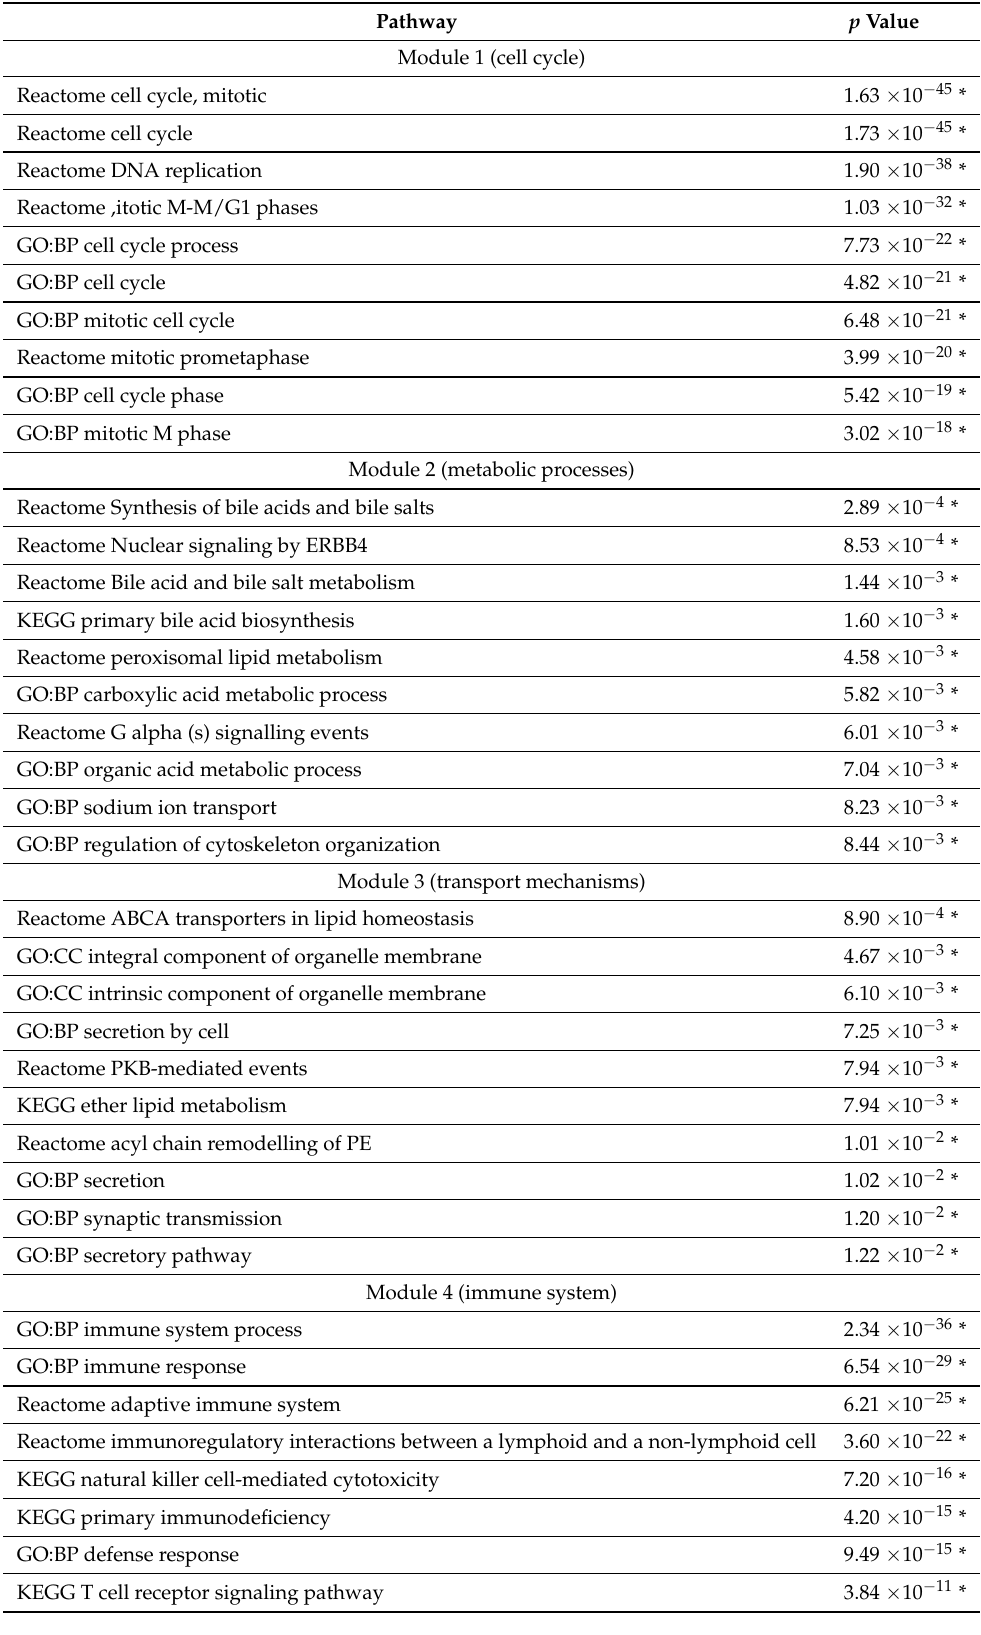
Table 5. The pathway enrichment analysis of each module by GO, KEGG, and Reactome pathway databases for the breast cancer (METABRIC) dataset. The * sign indicates the p -value is significant under a false discovery rate of